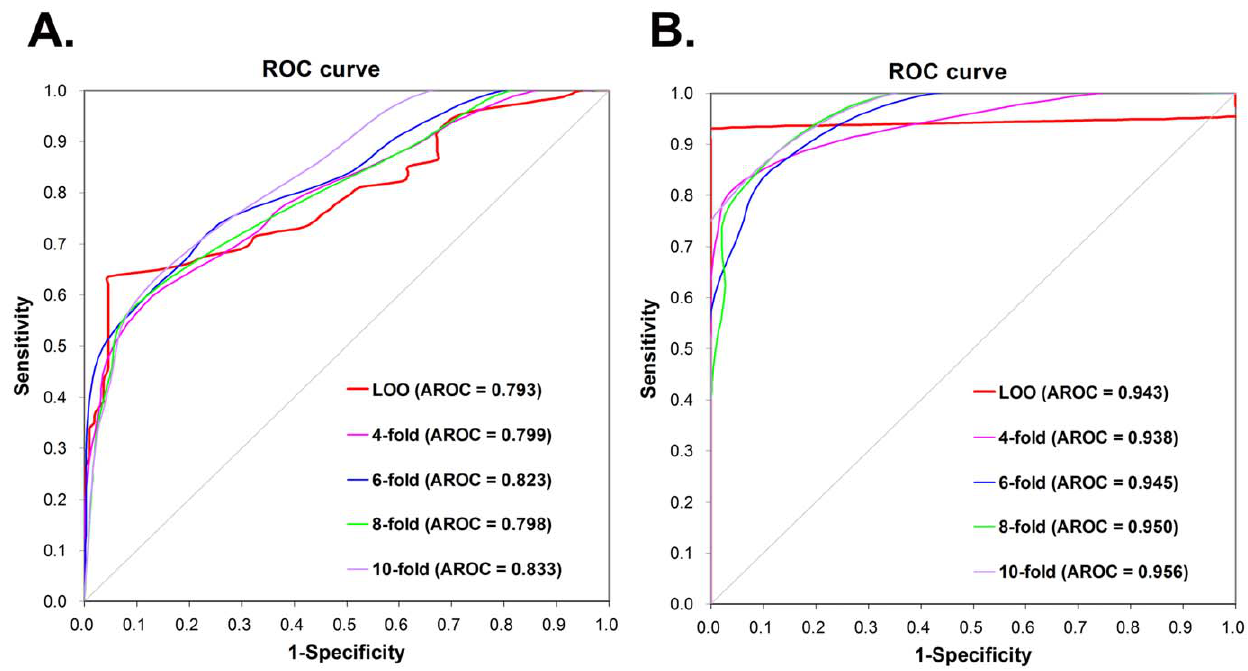
Figure 3. The prediction performance of GPS-ARM 1.0. The LOO validation and 4-, 6-, 8- and 10-fold cross-validations were performed for (A) the D-box and (B) the KEN-box.